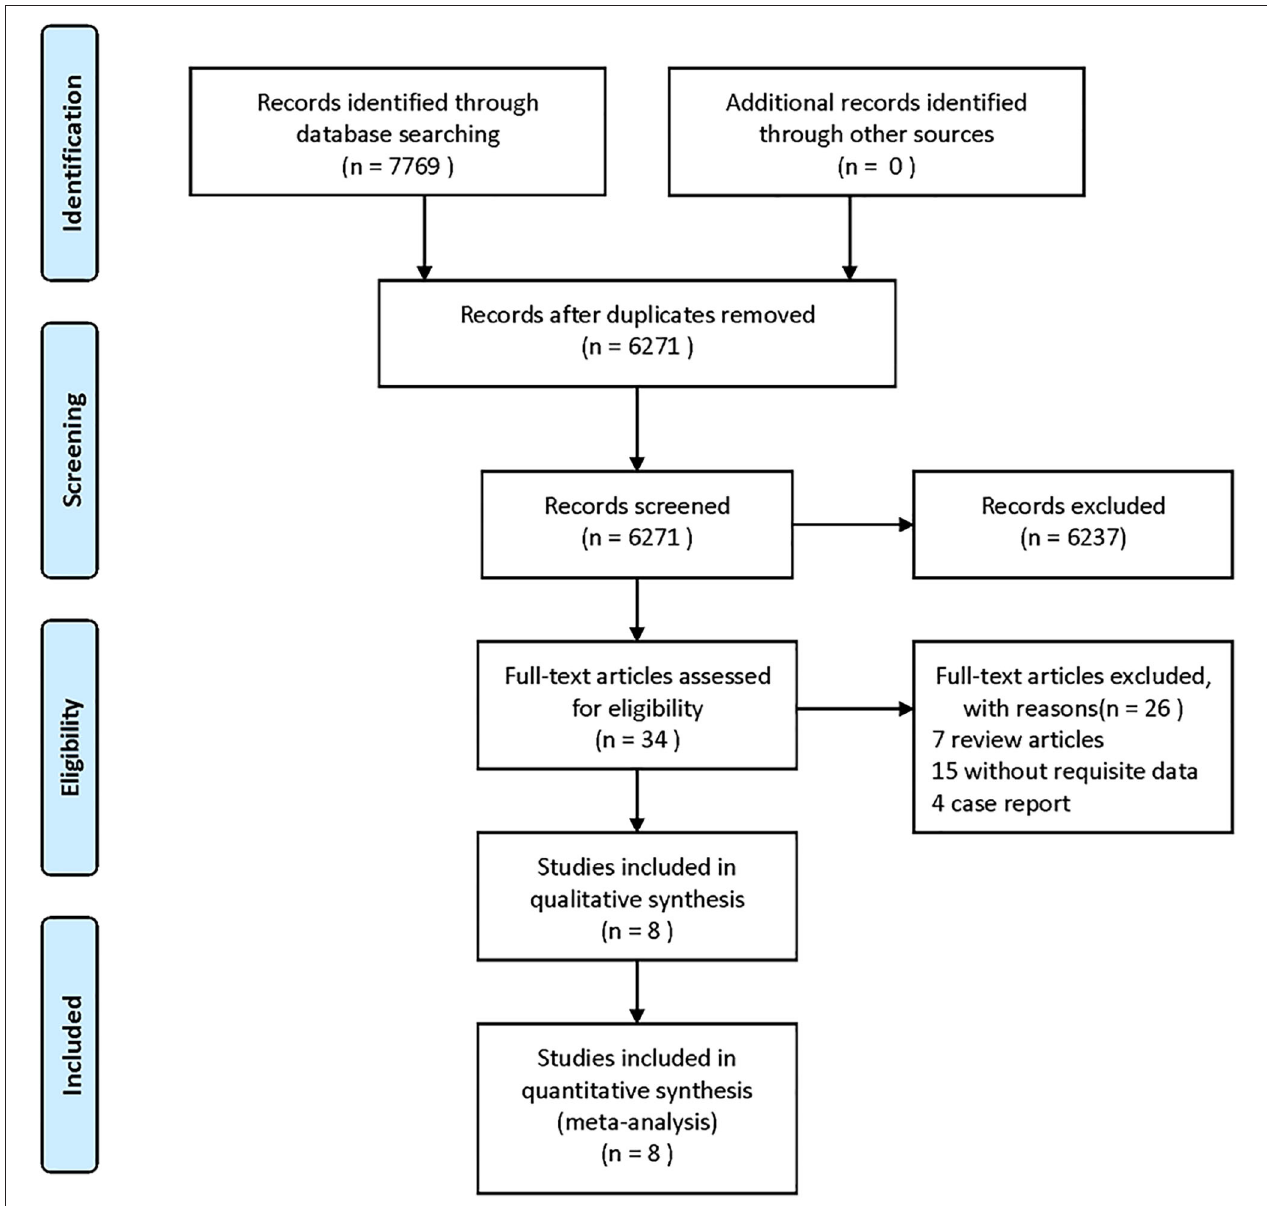
FIGURE 1 | Flow diagram of the study selection process.